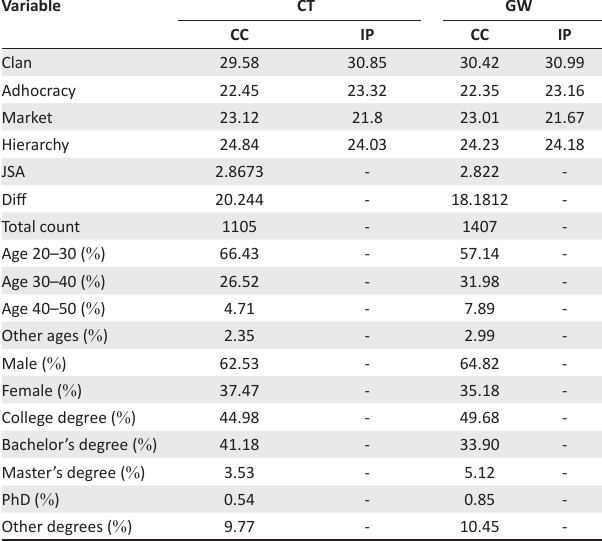
FIGURE 1: Organisational culture cognition difference of creative talents.